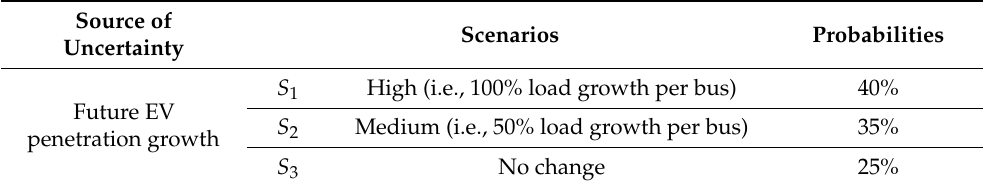
Table 1. Description of the source of uncertainty in the problem through three scenarios for EV penetration. Source of Uncertainty